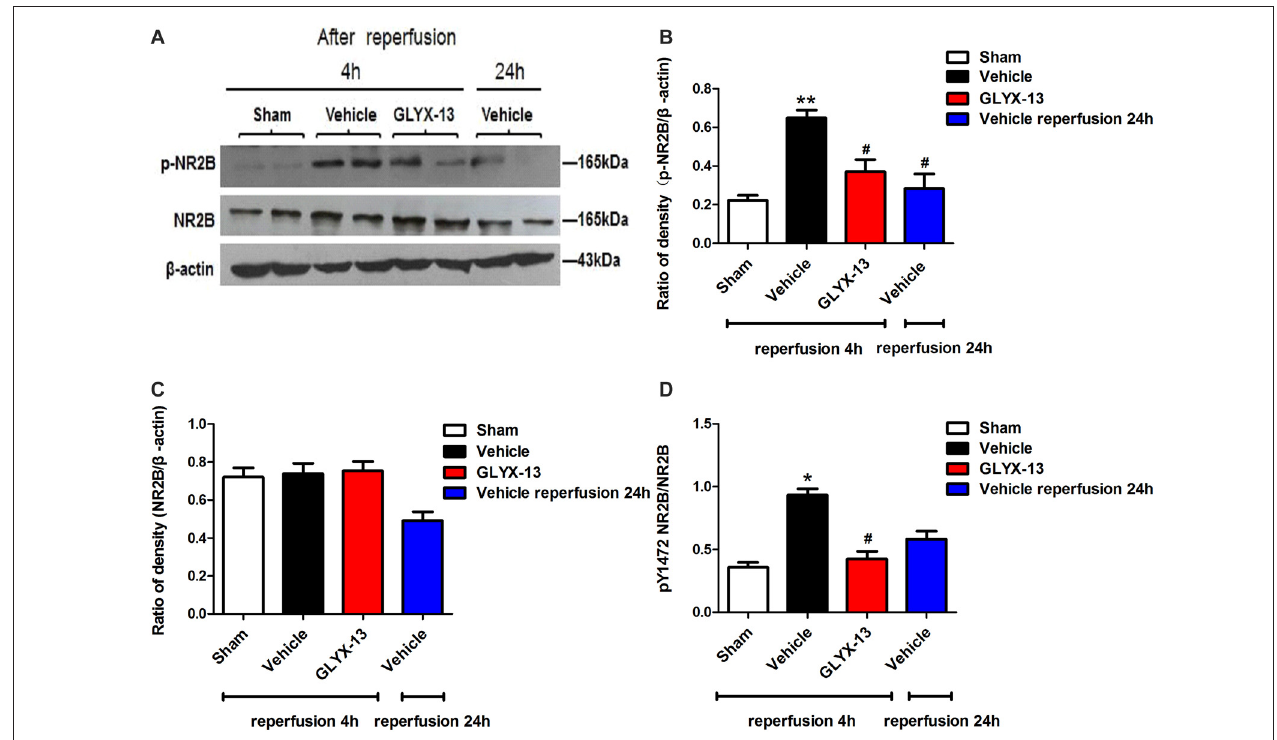
FIGURE 5 | GLYX-13 reduced the expression of pY1472 NR2B 4 h after reperfusion. (A) Representative images of western blot. The intensity of each band was quantified by image j and normalized in relation to β -actin. (B–D) Statistical analysis of densitometric data from indicated experimental groups. The values are expressed as mean ± SEM, n = 3 independent experiments. One-way ANOVA and Newman-Keuls post test, ∗ p < 0.05, ∗∗ p < 0.01, vs. Sham; # p < 0.05, vs. Vehicle.